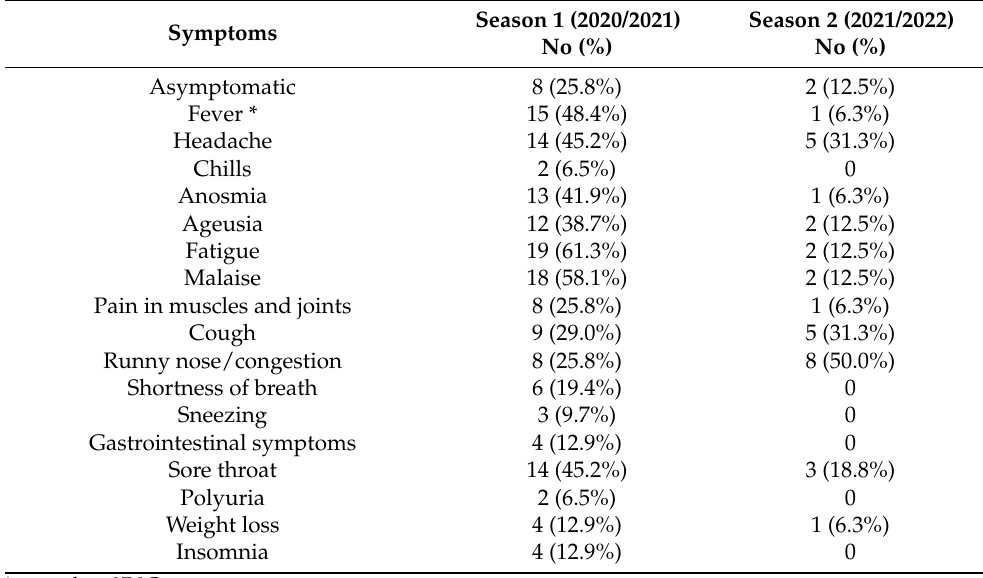
Table 2. COVID-19 symptoms among infected players.